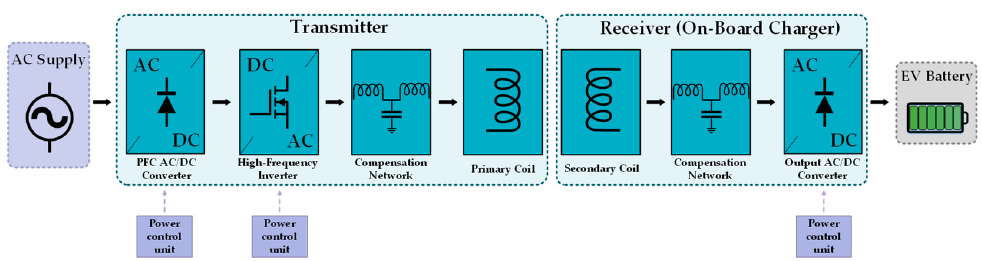
Figure 4. Block diagram of a unidirectional inductive charger.